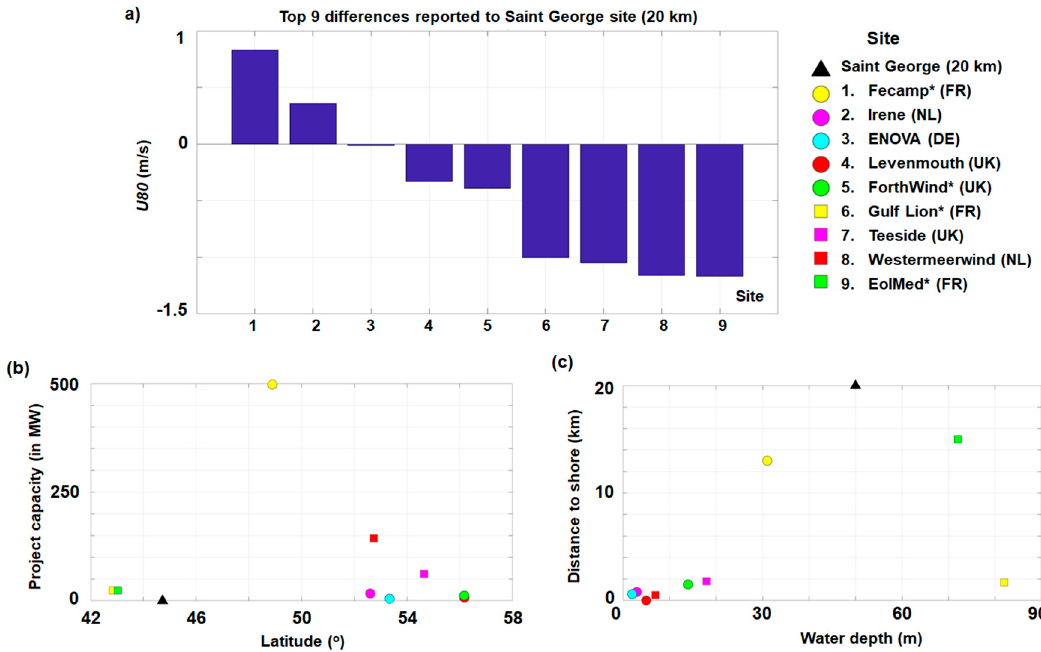
Figure 14. Direct comparison between the wind conditions reported close to the Saint George area (20 km offshore) and some European wind projects. The projects under construction are marked with the asterisk symbol (*). Results indicated for: ( a ) U 80 differences considering Saint George as a reference; ( b ) associated project capacities and latitudes; ( c ) associated distance to shore and water depth. Results available for the 20-year time interval from January 1998 to December 2017.